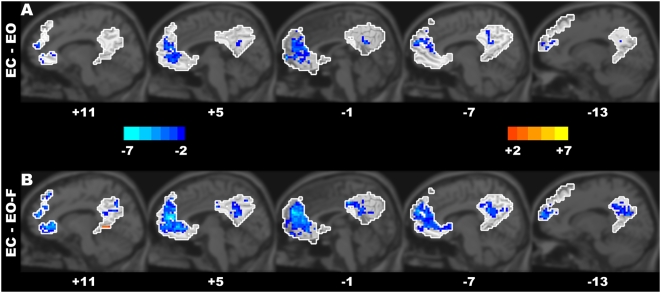
The between-condition differences of the ALFF within the DMN.The ALFF differences were found between the EC and EO conditions (A), and between the EC and EO-F conditions (B). The areas in the white contours denote the ROIs within the DMN. The numbers below the images refer to the x coordinates in the Talairach and Tournoux space. The statistical threshold was set at |t|>2.093 (P<0.05) and cluster size >486 mm3, which corresponds to a corrected P<0.05.